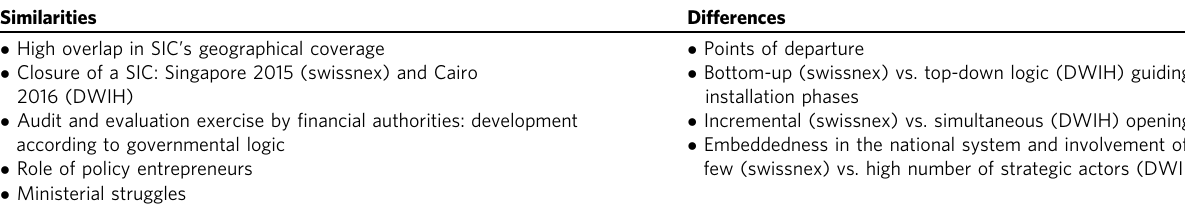
Table 3 Comparing the development of SIC in Germany and Switzerland. Similarities